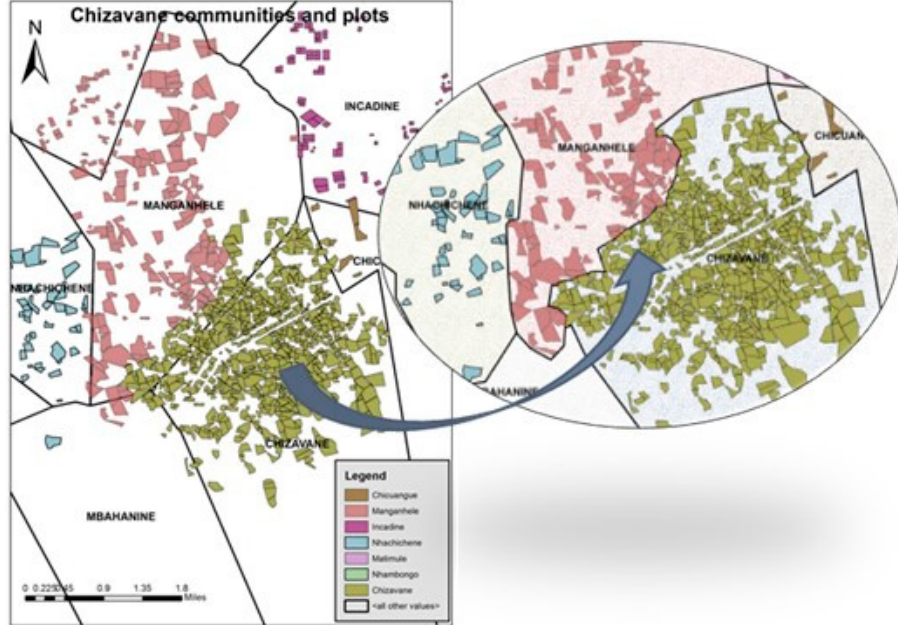
Figure 6. Example of the adjustments made to the community boundaries based on the individual parcels’ registrations.